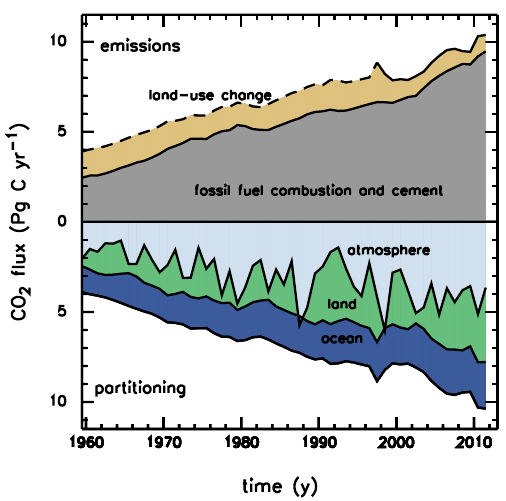
Figure 2. Combined components of the global carbon budget illus- trated in Fig. 1 as a function of time, for (top) emissions from fossil fuel combustion and cement production ( E FF ; grey) and emissions from land-use change ( E LUC ; brown), and (bottom) their partition- ing among the atmosphere ( G ATM ; light blue), land ( S LAND ; green) and ocean ( S OCEAN ; dark blue). All time series are in PgCyr − 1 . Land-use change emissions include management–climate interac- tions from year 1997 onwards, where the line changes from dashed to